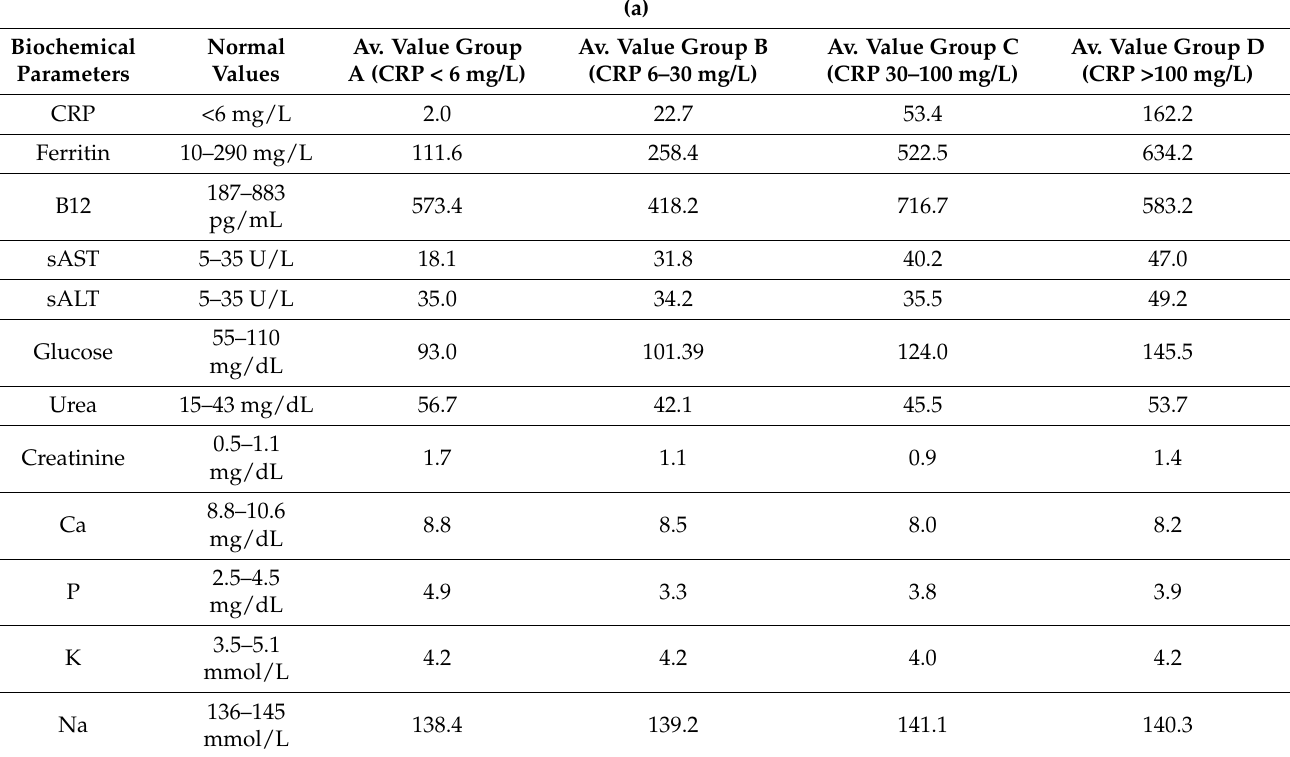
Table 6. (a): Biochemical parameters according to CRP values in females; (b) biochemical parameters according to CRP values in males; (c) biochemical parameters in COVID-participants according to